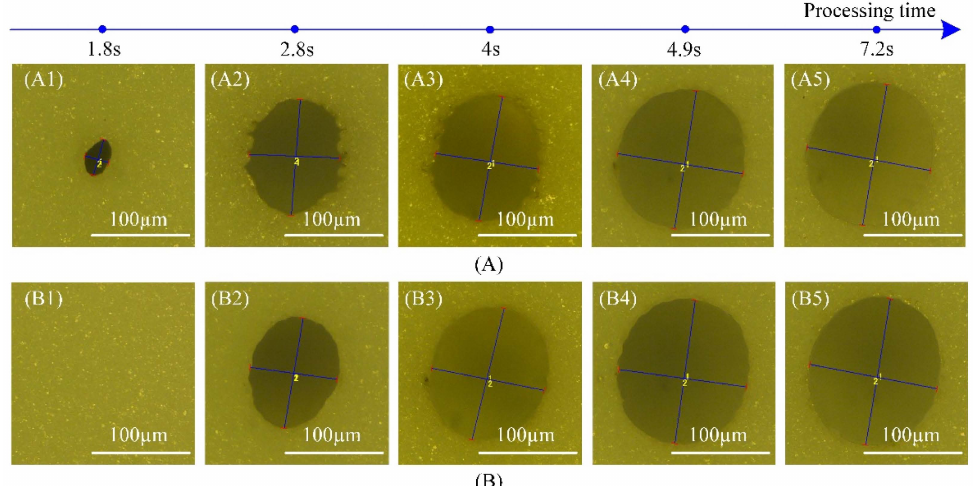
Figure 4. Outlets ablated using both laser trepanning patterns in 0.38 thick Al 2 O 3 ceramics (figure obtained by OM), ( A ) OM of outlet ablated by filled spiral laser trepanning, ( A1 ) The central region was penetrated, ( A2 , A3 ) The outlet was expanded, ( A4 ) The outlet reached the saturated state, ( A5 ) The outlet was modified, ( B ) OM of outlet ablated by multiple rings laser trepanning, ( B1 ) Unshaped, ( B2 ) The outlet formed, ( B3 ) The outlet was expanded, ( B4 ) The outlet reached the saturated state, ( B5 ) The outlet was